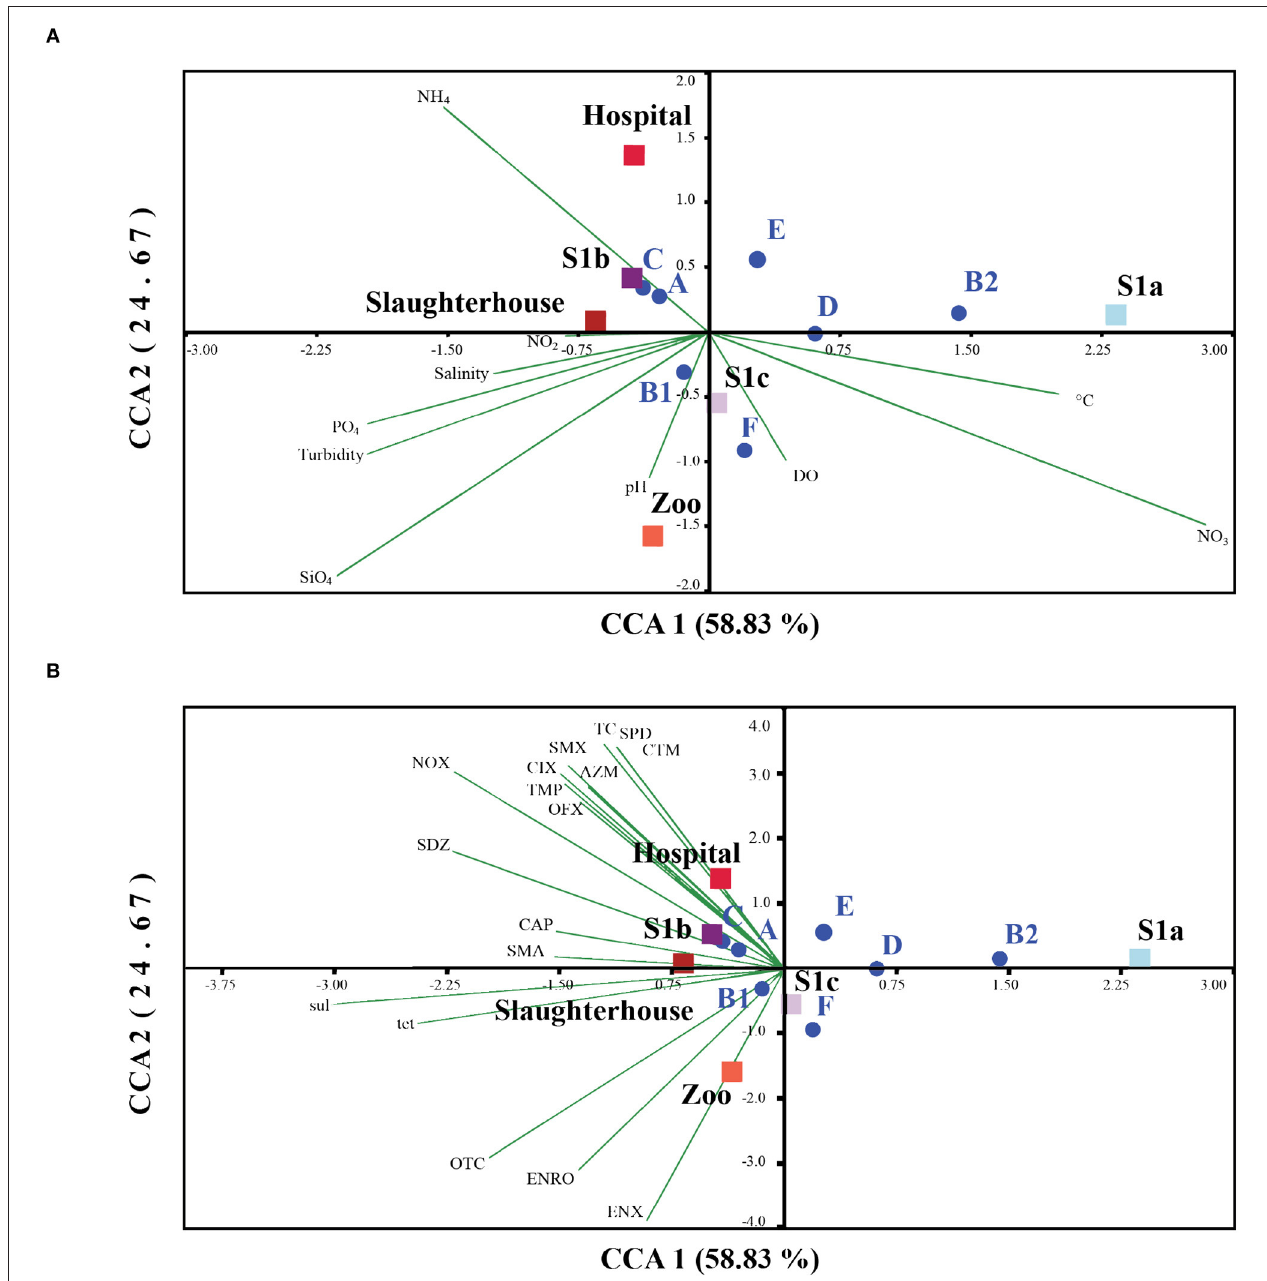
FIGURE 5 | Square root normalized CCA ordination biplot showing the distribution of E. coli phylogenetic groups by sampling sites in Larut River with respect to their phylogenetic group and resistance genes tet and sul . CCA 1 on axis 1 explained 52.60% whereas CCA 2 on axis 2 explained 25.81% of all explanatory variables. (A) Relationship between E. coli and water physicochemical parameters of Larut River collected by Lye et al. (29). (B) Relationship between E. coli and water antibiotic residue detected in Larut River collected by Low et al. (42). Water physicochemical factors abbreviation: Temp ( ◦ C), salinity (ppt), pH, dissolved Oxygen (DO), turbidity and concentrations ( µ M) of Silicate (SiO 4 ), Ammonium (NH4), Nitrite (NO 2 ), Nitrate (NO 3 ), Phosphate (PO4). Antibiotic resistance gene: sul , sulfonamide resistance gene; tet , tetracycline resistance gene. Antibiotic residue: RTM, Roxithromycin; CTM, clarithromycin, AZM, azithromycin; ETM-H 2 O, erythromycin-H 2 O; ENX, enoxacin; ENRO, enrofloxacin; NOX, norfloxacin; OFX, ofloxacin, CIX, ciprofloxacin; CTC, chlortetracycline; OTC, oxytetracycline; TC, tetracycline; FF, florfenicol; CAP, chloramphenicol; TMP, trimethoprim; SAAM, sulfacetamide; STZ, sulfathiazole; SDM, sulfadimethoxine; SMA, sulfadimidine; SPD, sulfapyridine; SDZ, sulfadiazine; SMX,